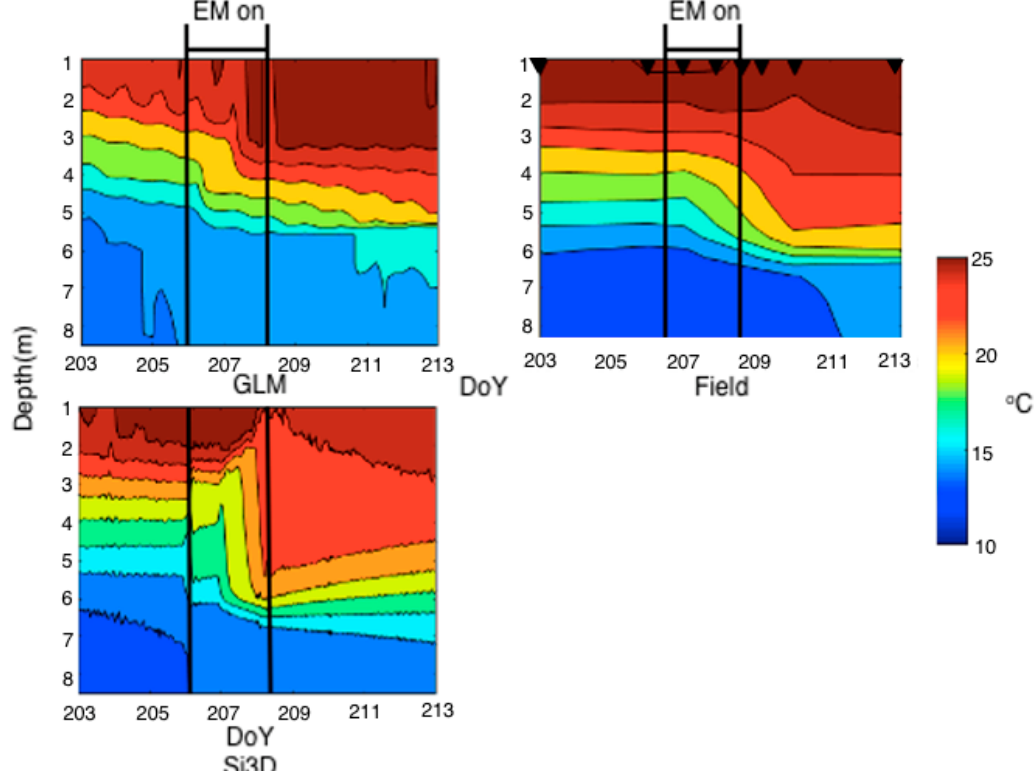
Figure 6. Comparison of the simulated temperature and field data for EM16–3 at FCR50. The time of the field data collection is indicated by black inverse triangles on the plot of the field data. To further evaluate the performance of the 1-D and 3-D models with EM, the met- alimnion bottom depths are calculated for the field and simulated data, which are plotted in Figure 7. While both GLM-AED2 and Si3D-AED2 reasonably simulate the increase of metalimnion bottom depth during EM operation, it is clear in Figure 7 that Si3D-AED2 predicts the plume temperature structure much better than GLM-AED2 for all the EM periods. Quantitative analysis presented in Table 7 also proves this with lower RMSEs of the simulated metalimnion bottom depth in all four simulations by Si3D compared to those by GLM. This observation indicates that Si3D-AED2 instead of GLM-AED2 should be adopted if artificial mixing is in operation. A similar conclusion was drawn by Chen et al. [20], who studied the 3-D effect of artificial mixing on thermal structures in FCR and found that EM leads to 3-D heterogeneity in the thermal structures, which is impossible to capture by 1-D models. Accordingly, they concluded that 3-D models are more suitable than 1-D models for the design and operation of engineered systems although artificial mixing in lakes and reservoirs has mostly been studied with 2-D models [12,51]. The better performance of 3-D models may be due to their capability to simulate the horizontal mo- mentum added by the injected bubble, while 1-D models do not include horizontal mix- ing.